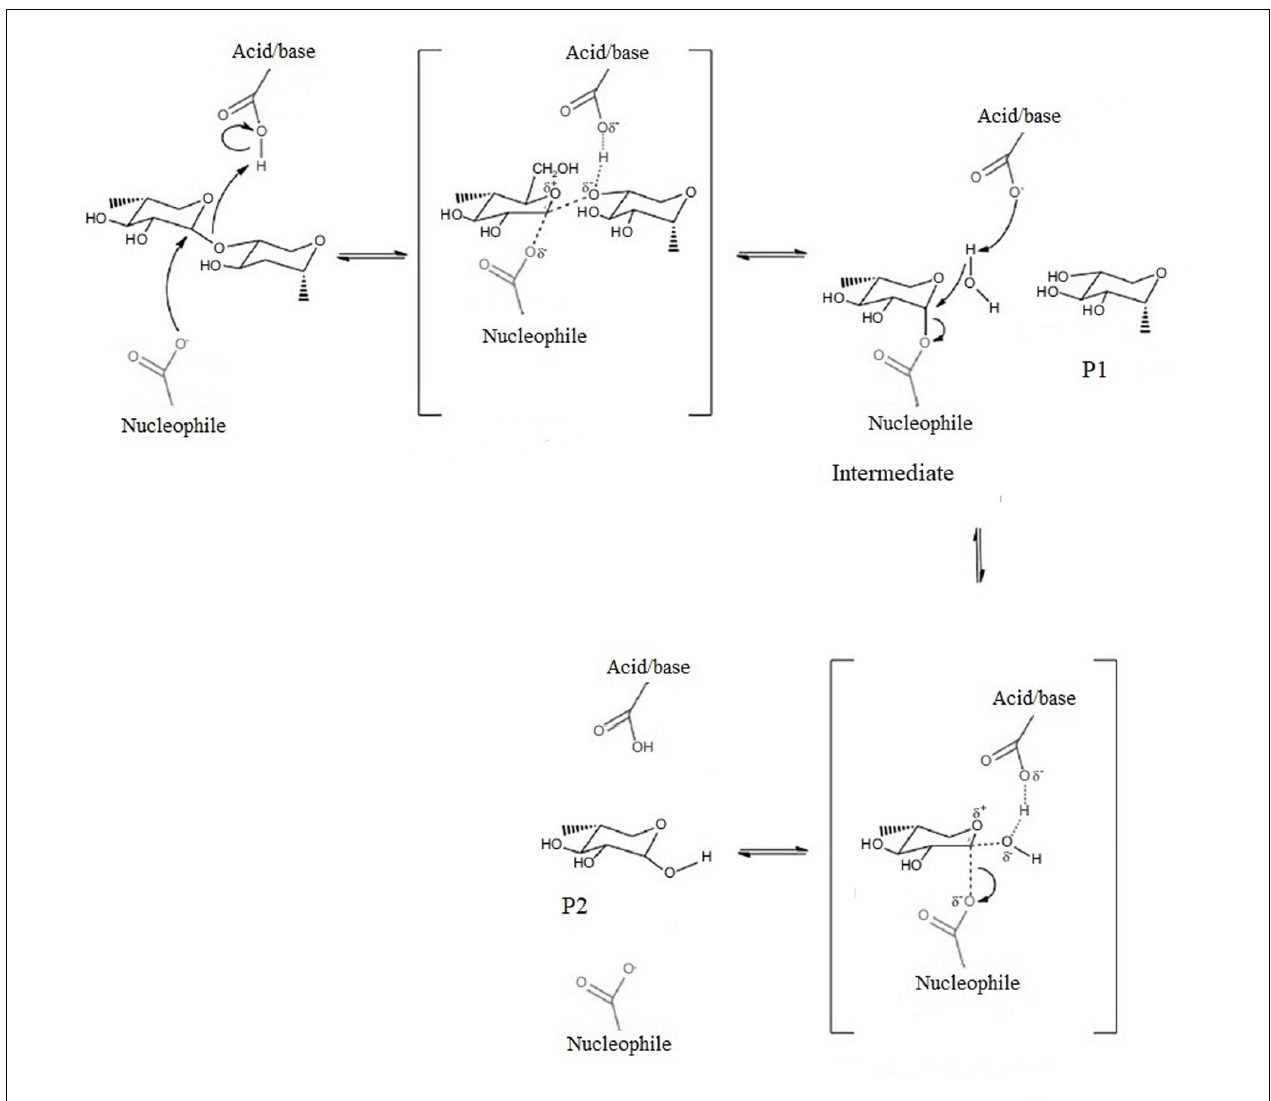
FIGURE 3 | Reaction mechanism of β -mannanase. Modified from Sharma et al. (2018). The brackets indicate transition state. P1 is product 1, P2 is product